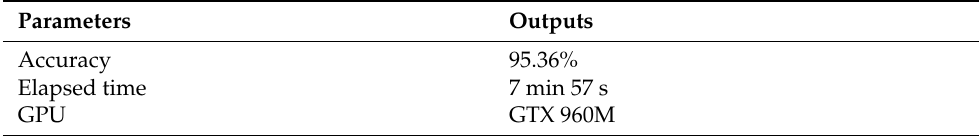
Figure 8. The loss rate. Table 5. Training Accuracy GoogLeNet CNN with the CT scan Dataset.